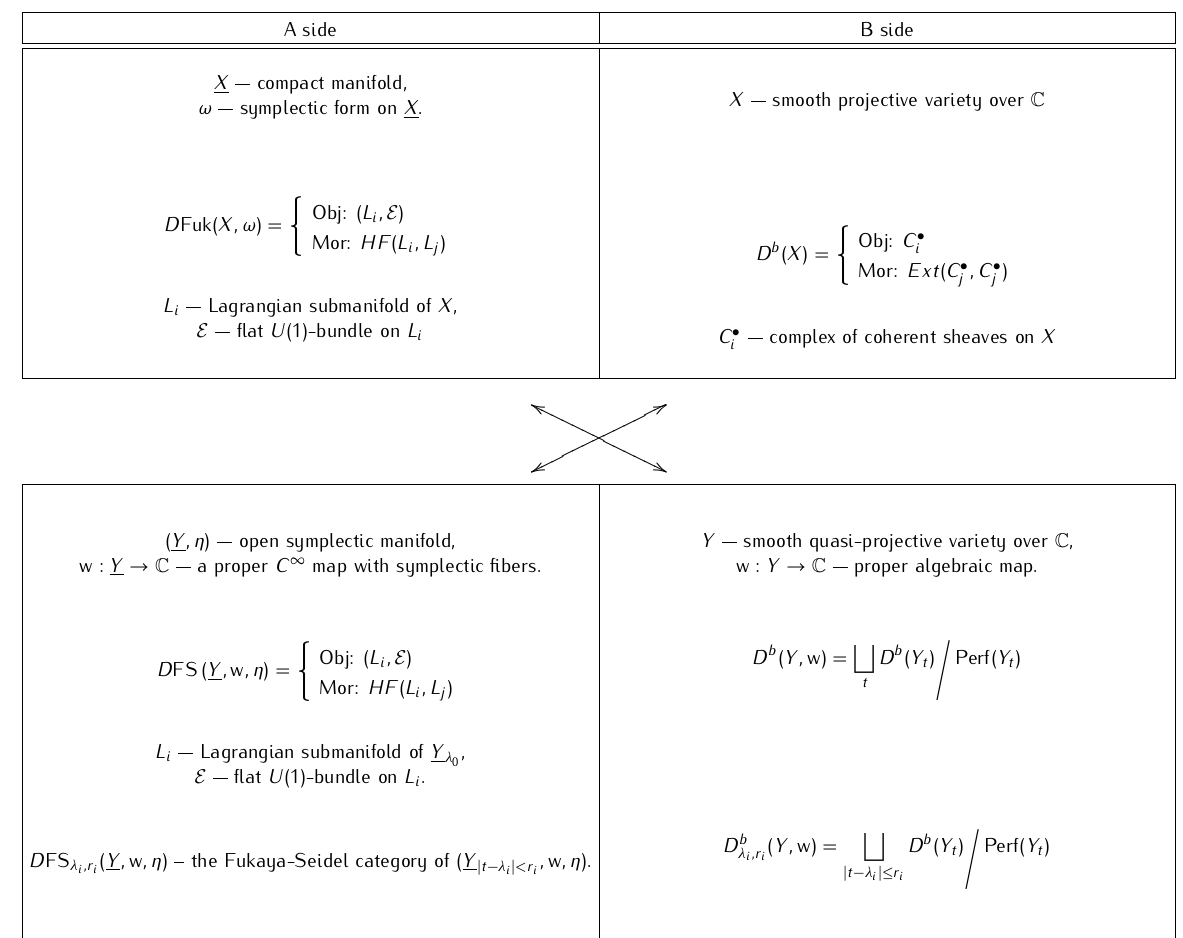
Table 1. Kontsevich’s HMS